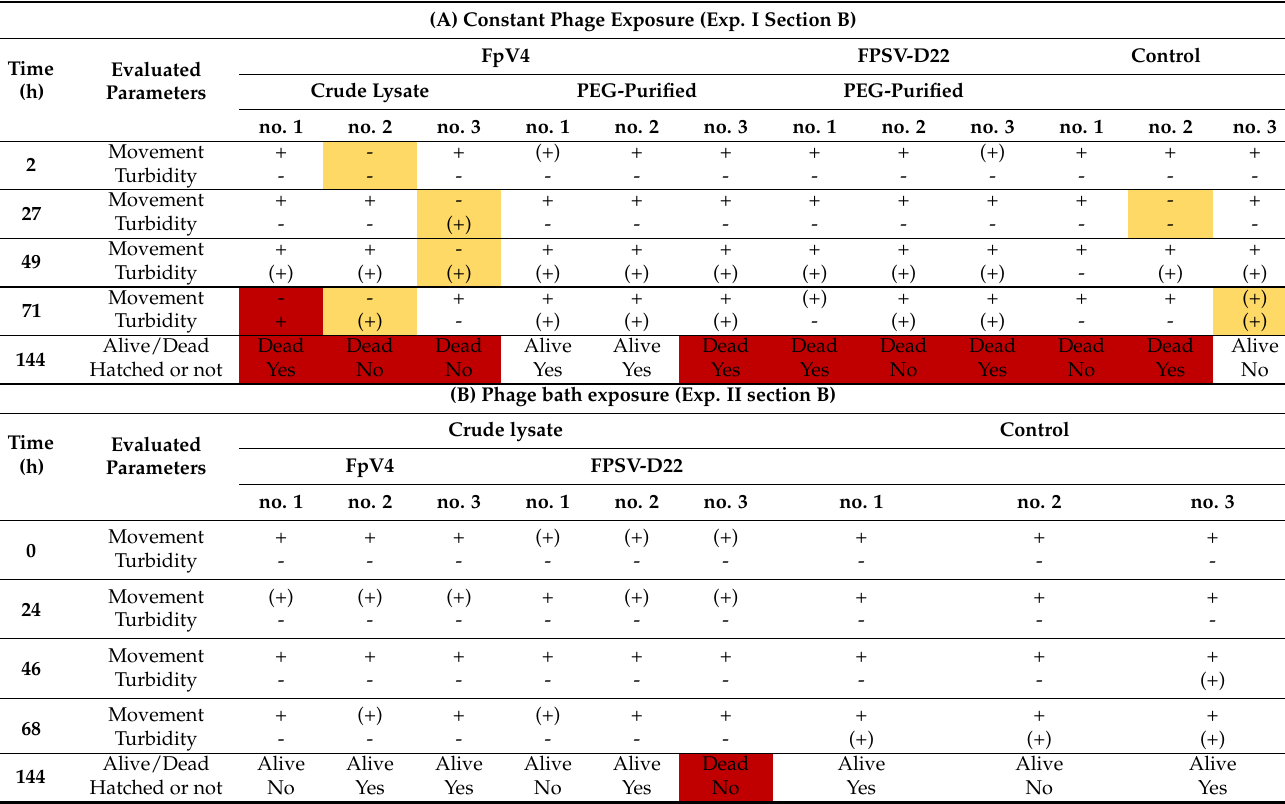
Table 2. Exp. I and II, section B: survival of rainbow trout eyed eggs exposed to phage FpV4 and FPSV-D22. In ( A ), characteristics of the eyed eggs during constant phage exposure (Exp. I). In ( B ), characteristics of the eyed eggs after a 4 h phage bath ( B , Exp. II). FpV4 and FPSV-D22 were diluted in sterile TYES-B. In yellow: not clear if the egg is alive (no movement and/or light turbidity); in red: the egg is dead (no movement and positive turbidity); not highlighted: the egg is alive. Time = hours of constant phage exposure in A and hours post-phage bath in B